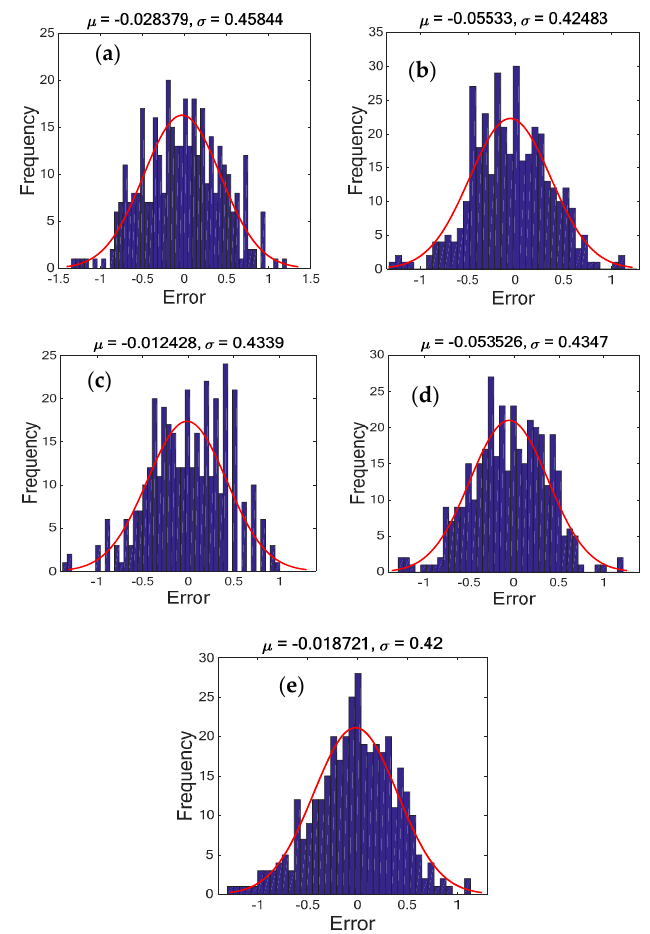
Figure 5. Error histogram of the best composite models (( a ) BRT, ( b ) MLPNN, ( c ) RBFNN, ( d ) MARS, and ( e ) KELM; Durham